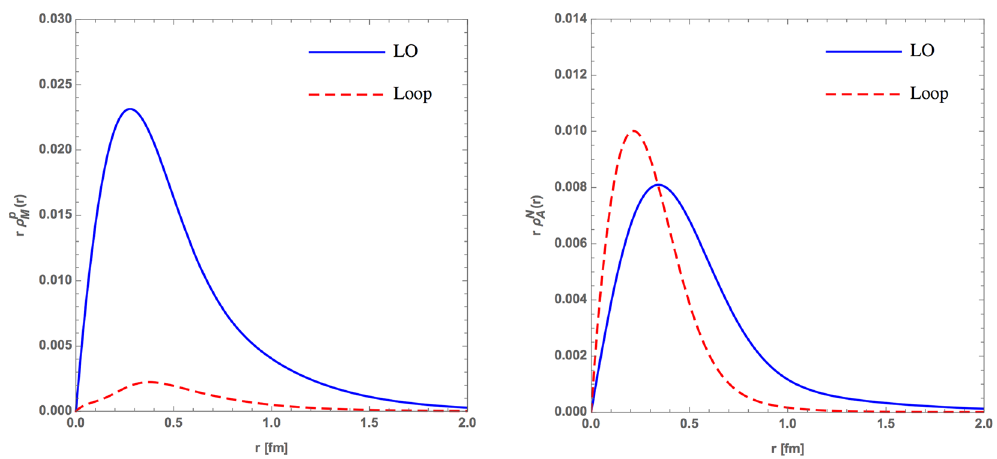
Figure 6. Comparisons between the LO and meson cloud distributions for proton magnetic (left panel) and axial (right panel) form factors in r